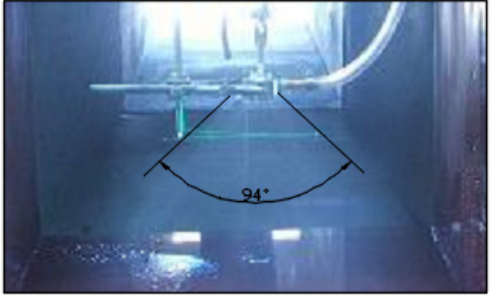
Figure 12. The spray torch angle of an air-assisted atomizer.